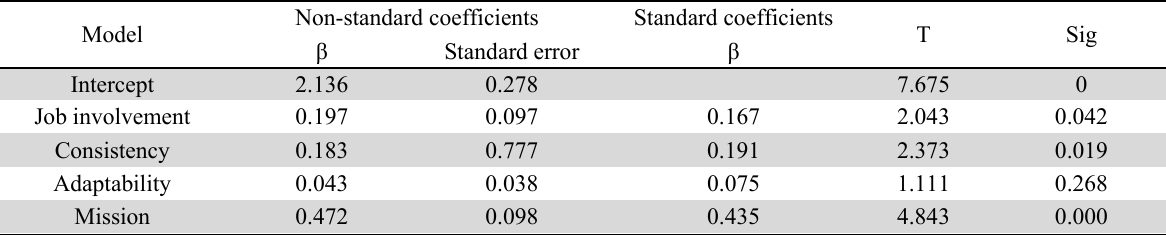
The results of regression analysis